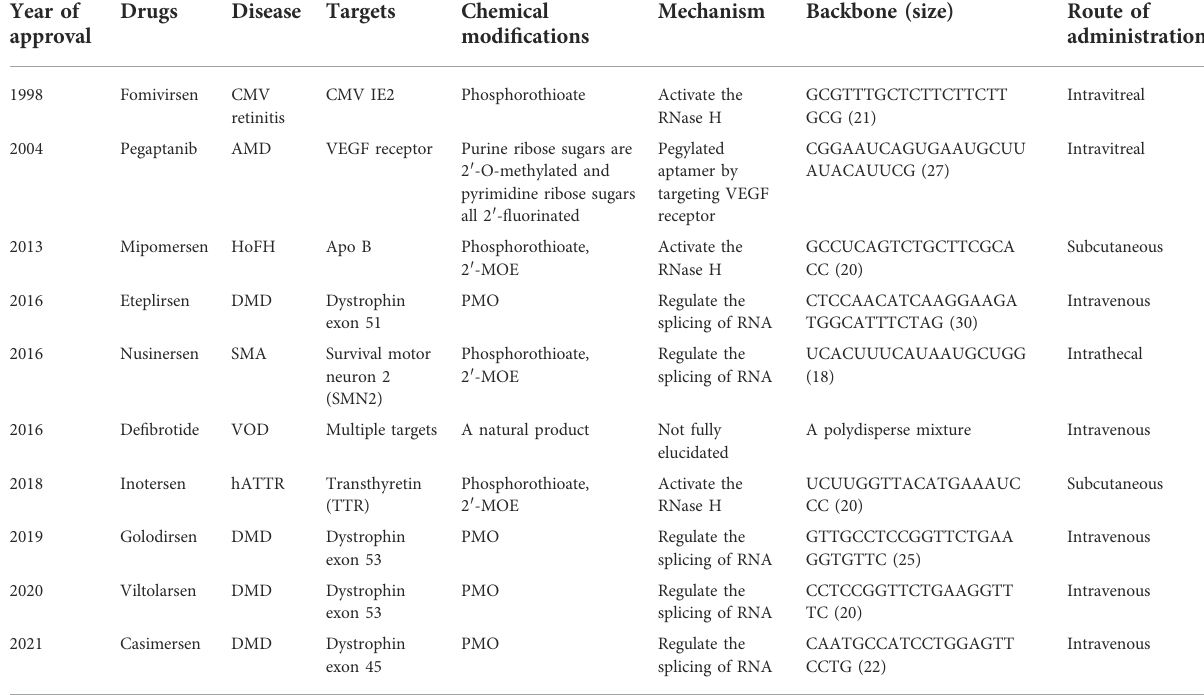
TABLE 1 Features and properties of FDA-approved ASO